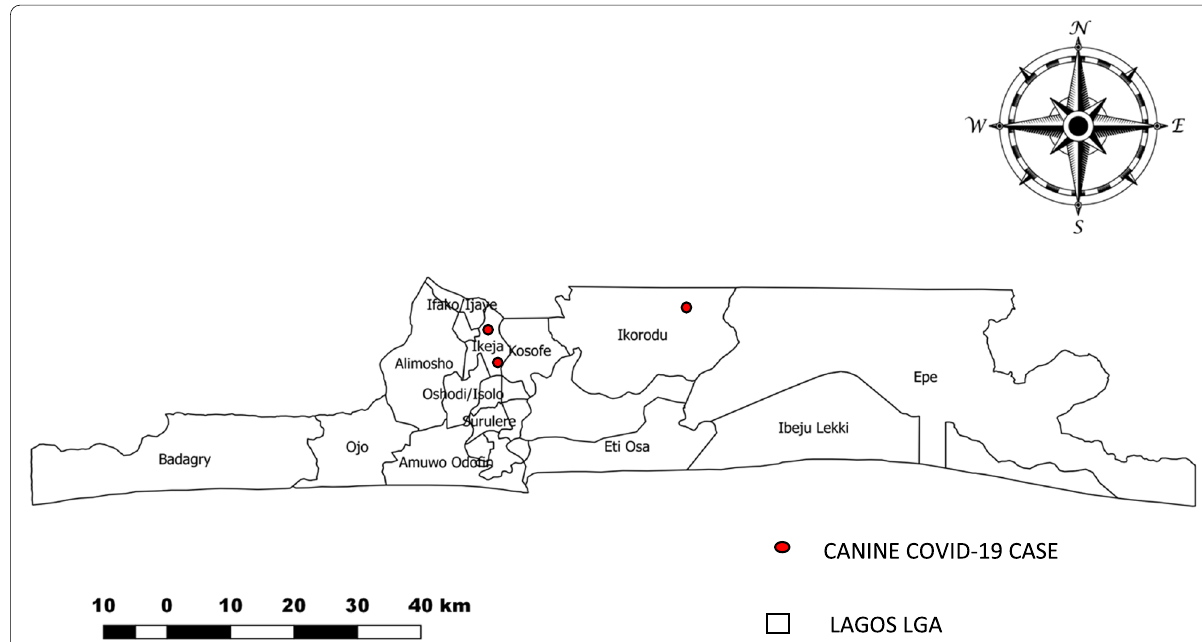
Fig. 3 Dogs SARS-CoV-2 cases in Lagos by LGA of residency, June to August 2020. This showed the number and distribution of positive COVID-19 cases among Canine in Lagos State, within the period of the study. A total of 2.0% of canine sampled returned a positive